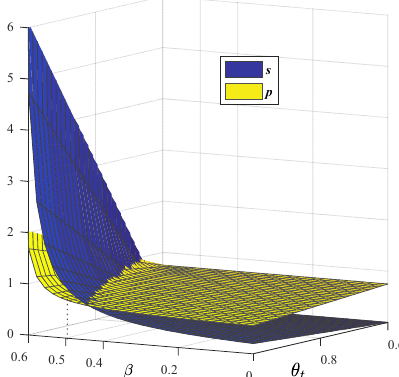
Figure 14. Price and service in Scenario D (3).